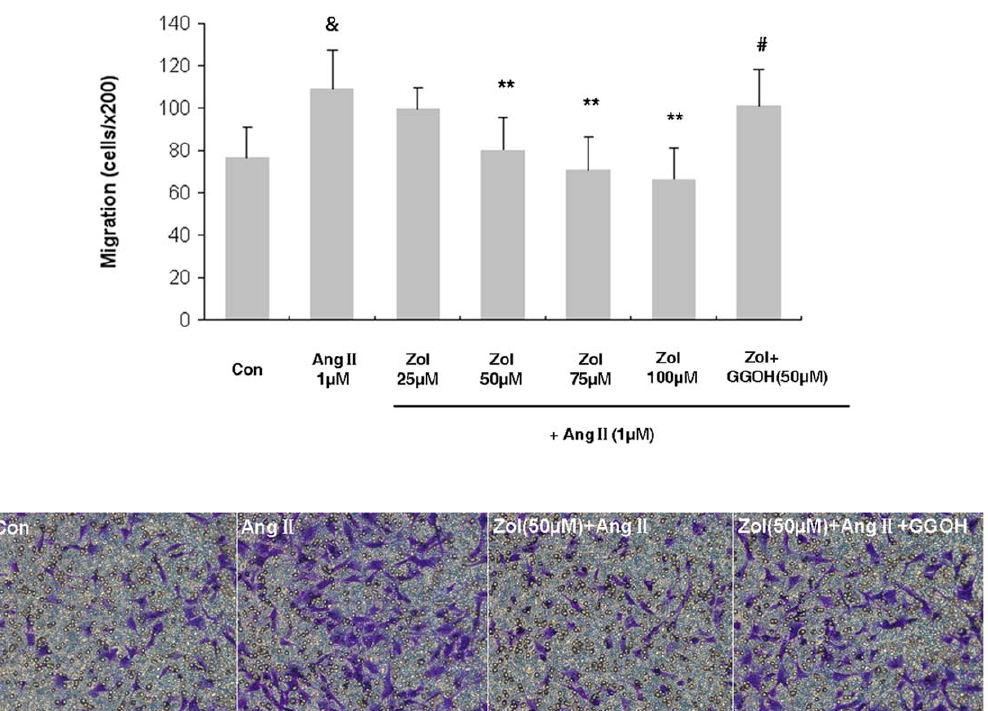
Figure 3. Migration of EPCs cocultured with Ang II and Zol. Migratory effect of EPCs was improved by Ang II, while impaired by Zol dose dependently and this effect could be reversed by GGOH. Data are presented as mean 6 SD, n=5. &P , 0.01 vs. control group; ** P , 0.01 vs. Ang II group; # P , 0.05 vs. 50 m M Zol + Ang II group.